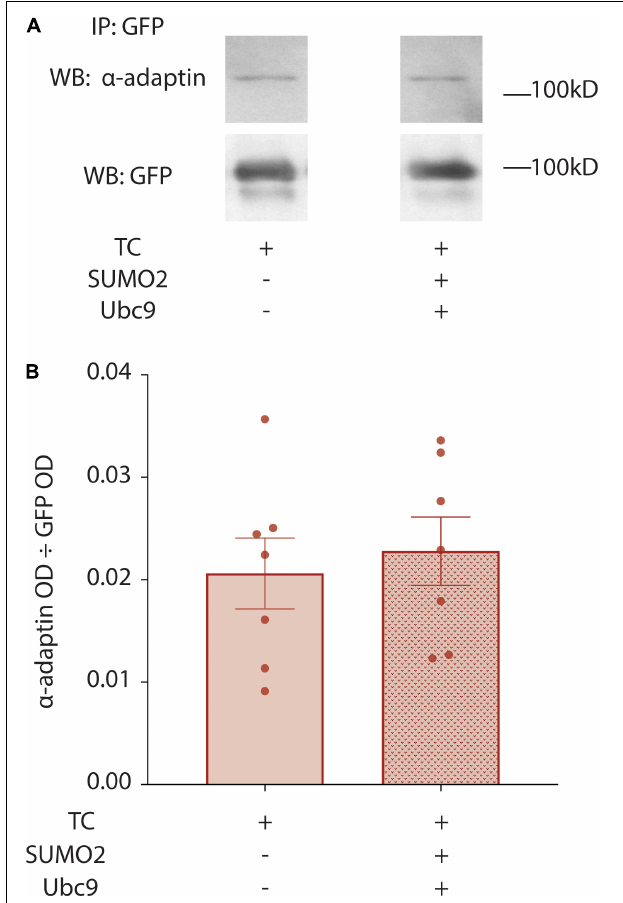
FIGURE 8 | Enhancing SUMOylation does not change the fraction of Kv4.2g associated with α -adaptin. HEK cells were co-transfected with the TC components, and SUMOylation was (+) or was not (–) increased by co-expressing SUMO2 and Ubc9. Kv4.2g IP was obtained from cell lysates using an anti-GFP antibody, and IP products were resolved with PAGE. Western blots were probed for α -adaptin and then stripped and re-probed for Kv4.2g. (A) Representative western blots for α -adaptin and Kv4.2g for control and enhanced SUMOylation treatment groups. (B) Bar graphs plotting the mean ± SEM of α -adaptin that co-IPs with Kv4.2g for each treatment group [OD α -adaptin ÷ OD Kv4.2g]. Each data point is one independent experiment. TC, 0.02 ± 0.0035 vs. TC + SUMO2 + Ubc9, 0.02 ± 0.0033; t -test p =